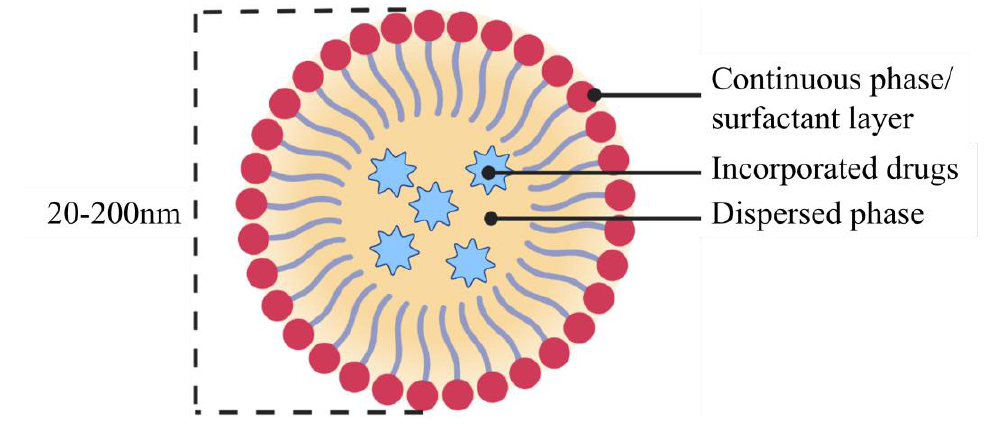
Figure 5. Schematic representation of an oil-in-water